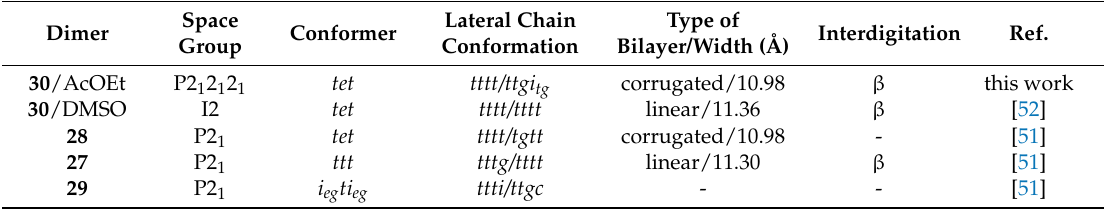
Table 4. Some characteristics of the crystal structures of the BE dimers analyzed in this paper.